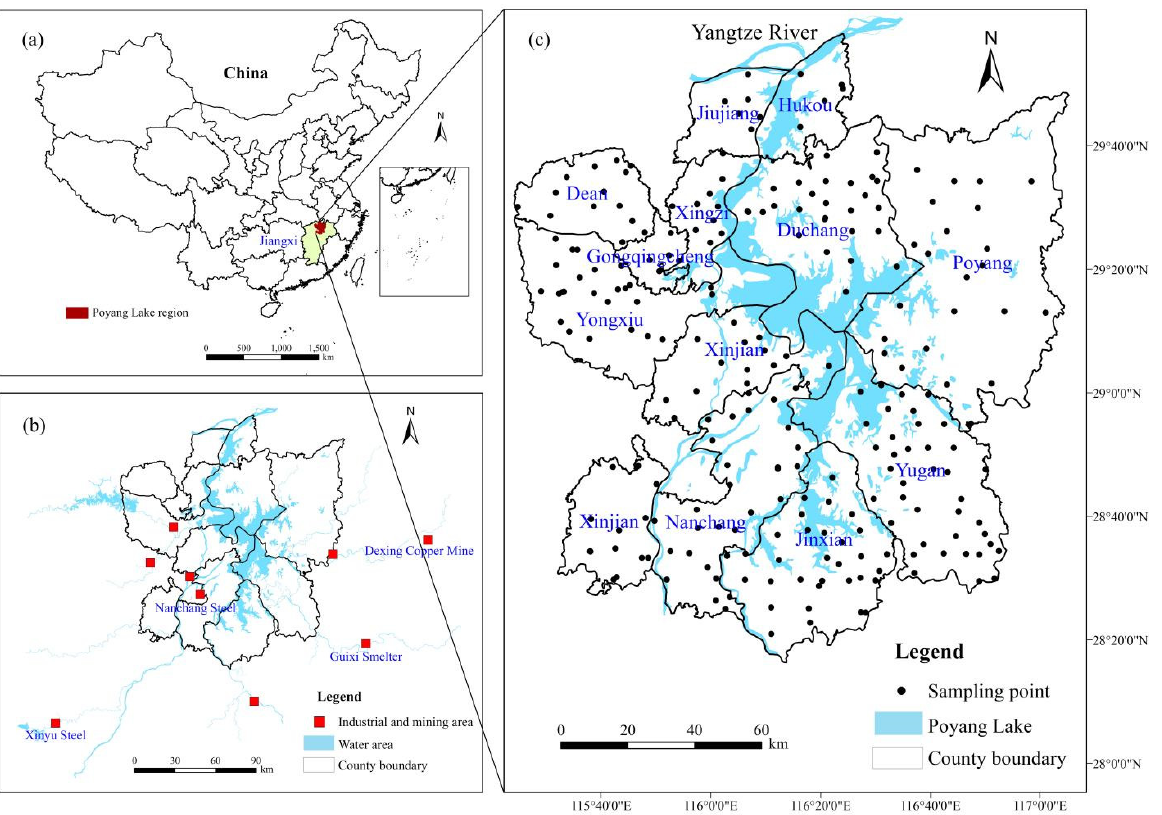
Figure 1. Geographical location of the study region in Jiangxi Province, China. ( a ) Poyang Lake region; ( b ) Major industrial and mining areas; and ( c ) Soil sampling points ( n = 251).